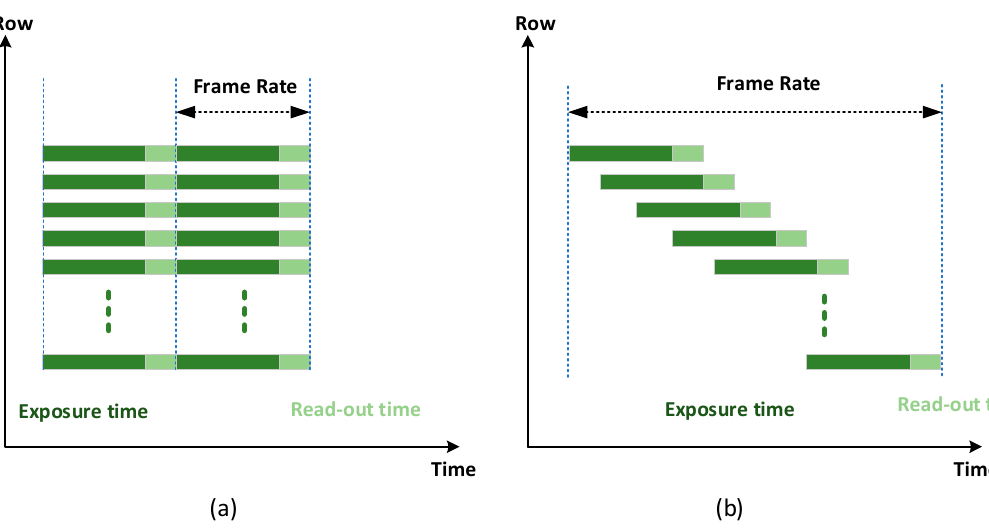
Figure 1. Sketch maps of the ( a ) global shutter of the CCD sensor, and ( b ) rolling shutter of the CMOS sensor.